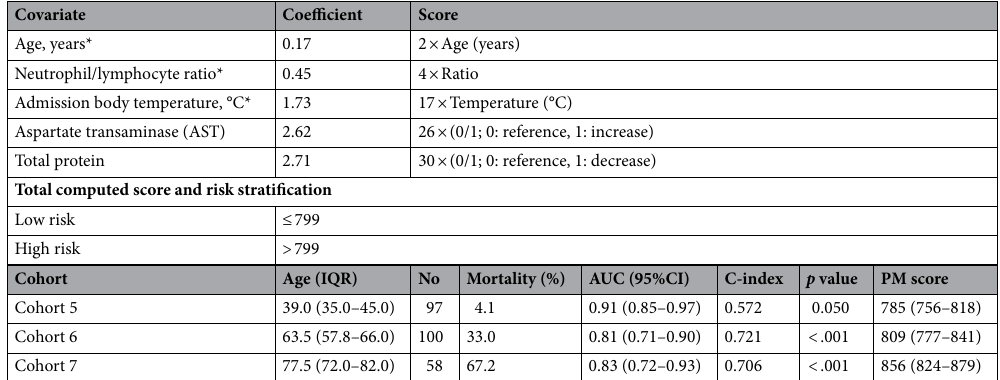
Table 3. Vital status and overall survival prediction in age-specific cohorts. *Continous variable; No. = Number of patients; AUC = Area under the curve; CI = Confidence interval; PM = Prognostic